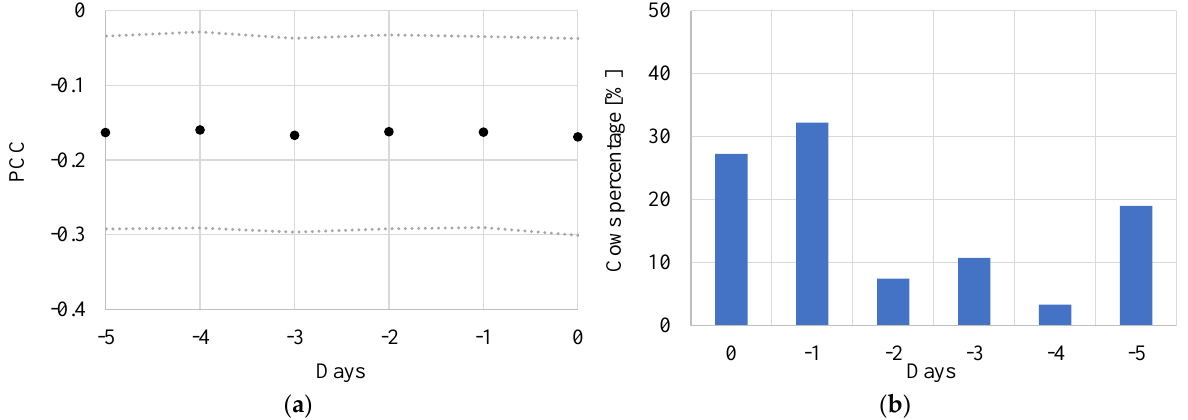
Figure 5. Correlation between milk yield and climatic data. ( a ) Pearson correlation coefficient: average values and average ± St. Dev. values. ( b ) Percentage distribution of cows vs. day with highest negative effects on milk production (i.e., the day with lower PCC for the single animal).